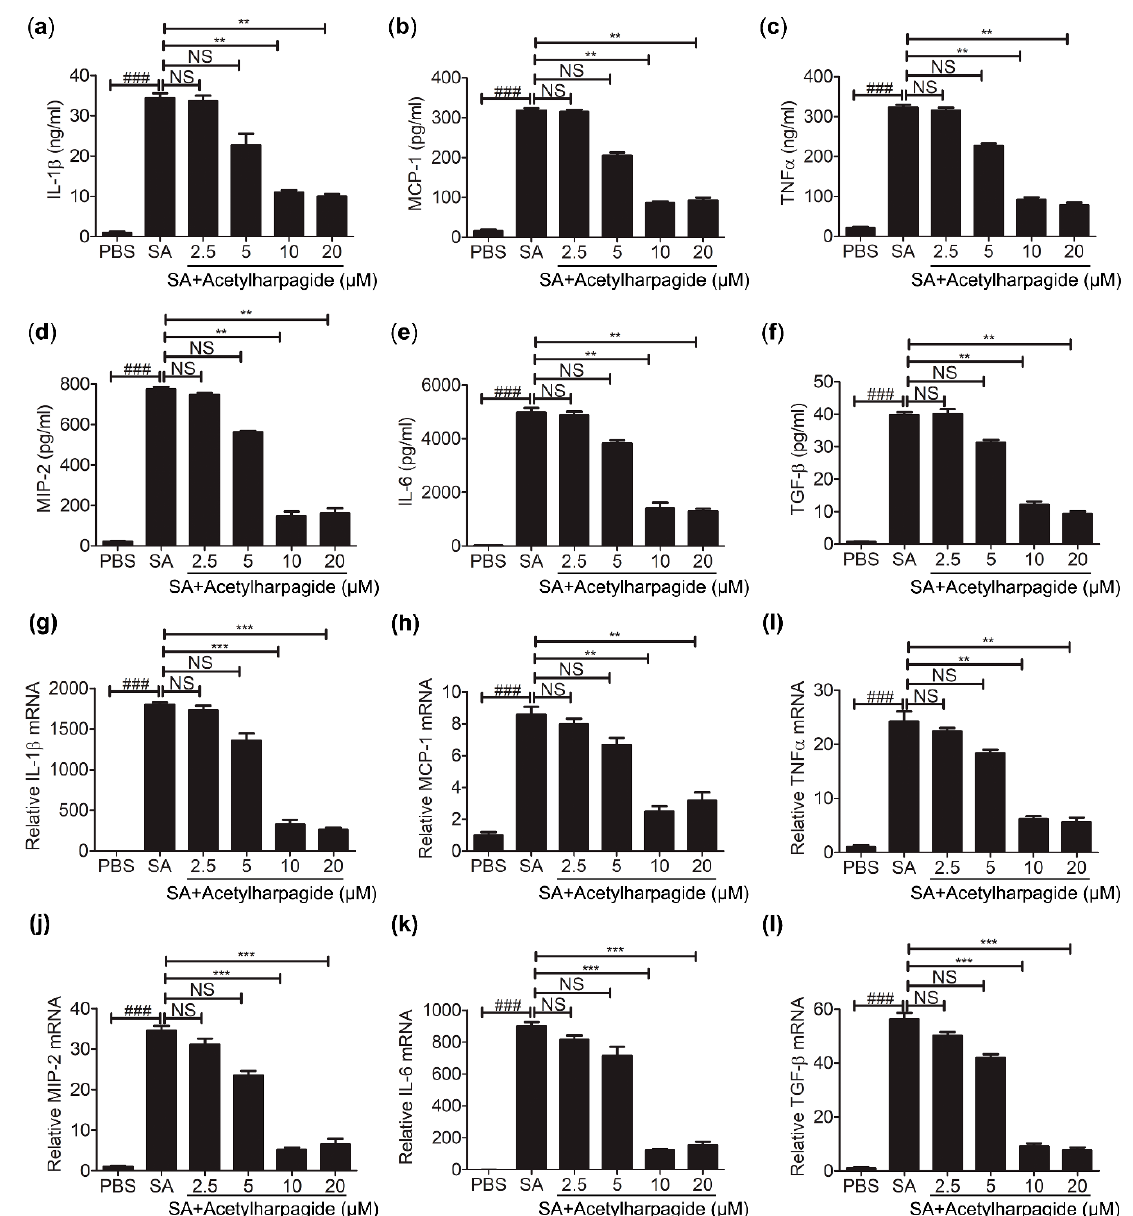
Figure 5. Acetylharpagide inhibited S. aureus (SA)-induced pro-inflammatory cytokines in macrophages. Raw264.7 cells were pretreated with acetylharpagide or DMSO for 2 h, then stimulated with S. aureus (multiplicity of infection (MOI), 10:1) for 2 h. ( a – f ) The culture medium was harvested and determined for the concentrations of IL-1 β ( a ), MCP-1 ( b ), TNF α ( c ), MIP-2 ( d ), IL-6 ( e ) and TGF- β ( f ) by ELISA. ( g – l ) The mRNA expression of IL-1 β ( g ), MCP-1 ( h ), TNF α ( i ), MIP-2 ( j ), IL-6 ( k ) and TGF- β ( l ) was determined by qPCR. The data were presented as mean ± SD, ### p < 0.001 vs. PBS+DMSO group, ** p < 0.01, *** p < 0.001 vs. SA+DMSO group, n = 3.